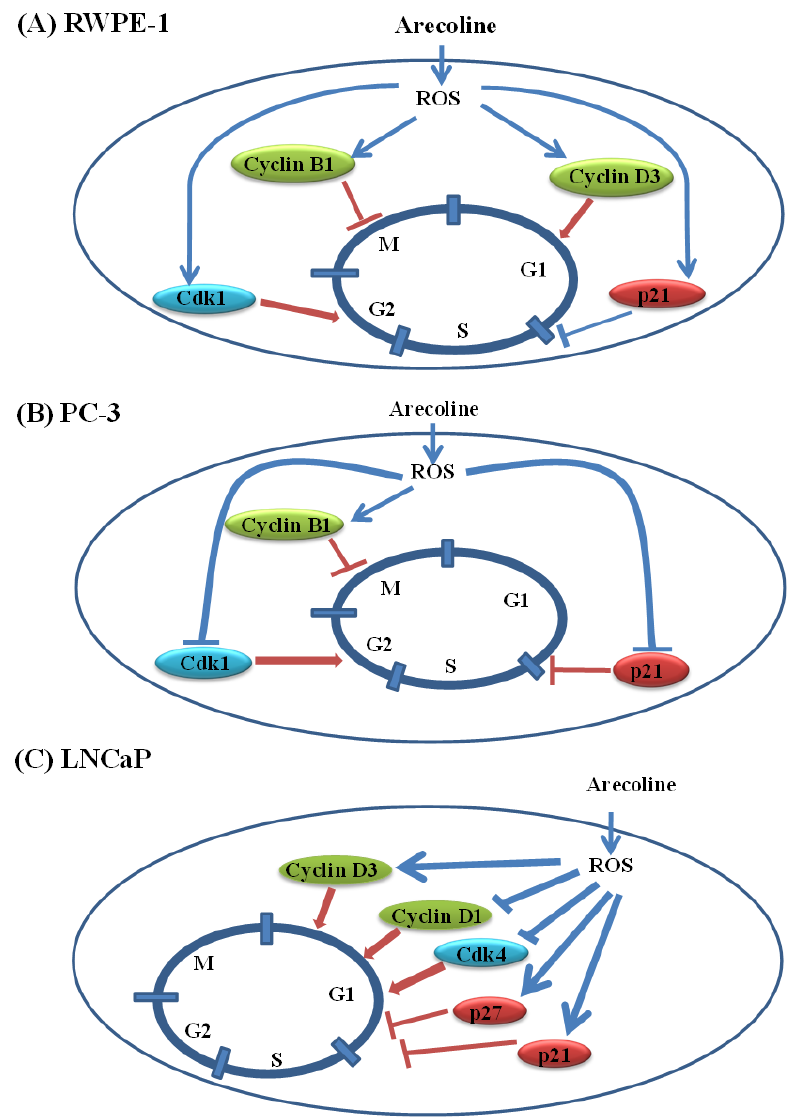
Figure 11. A proposed mechanism of the differential actions of arecoline on cell growth among RWPE-1 ( A ), PC-3 ( B ), and LNCaP ( C ) cells. The arecoline signaling was dependent on the cell cycle-controlling protein pathway, such as CDK1, CDK4, p21, p27, cyclin B1, or cyclin D3 proteins, in the reactive oxygen species (ROS)-dependent way. Thus, arecoline arrested RWPE-1 and PC-3 cells at the G2/M phase and LNCaP cells at the G0/G1 phase, leading to growth inhibition of all cells. The symbols of “ →”and“┤” were presented with either stimulatory or inhibitory effect of arecoline on protein expression.